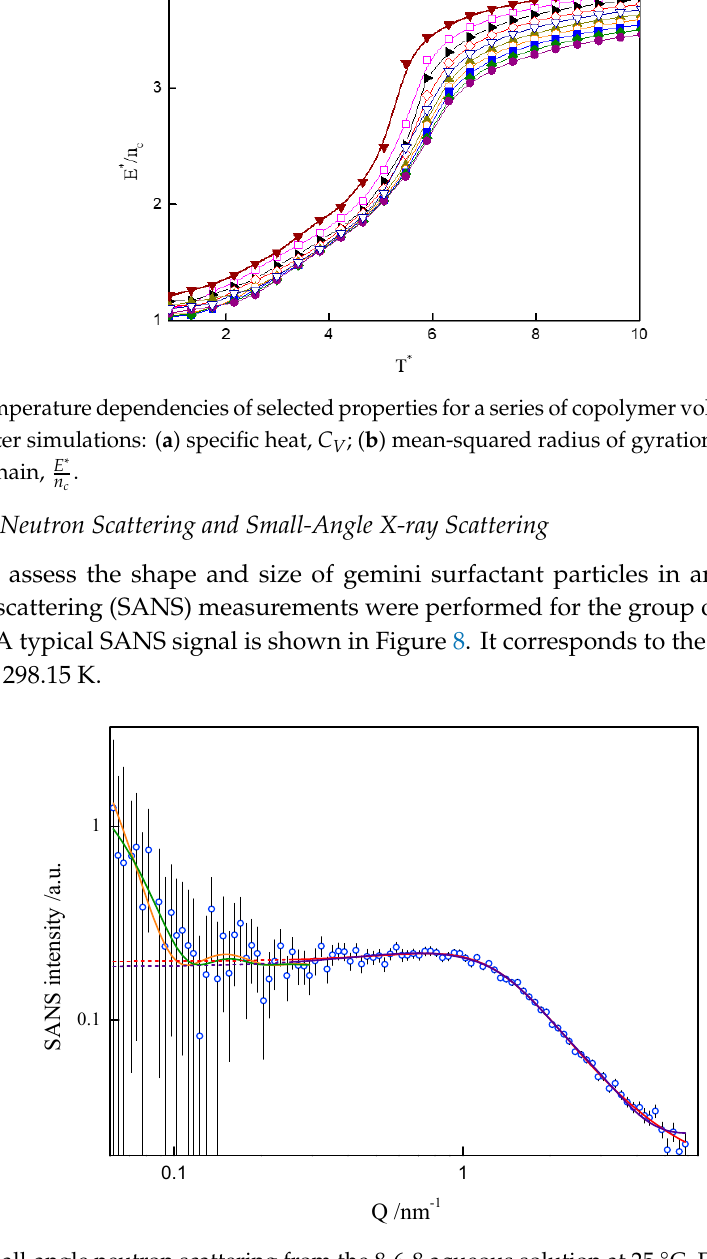
Figure 8. Small-angle neutron scattering from the 8-6-8 aqueous solution at 25 °C. Fit to data of four models, two models in low-Q and two in high-Q ranges, performed in low-Q and high-Q ranges separately: —lamellae, —polyelectrolyte, —charged ellipsoid, —fuzzy sphere. Dashed lines are extrapolations of mid- and high-Q models towards the low-Q end (not fitted in this region).